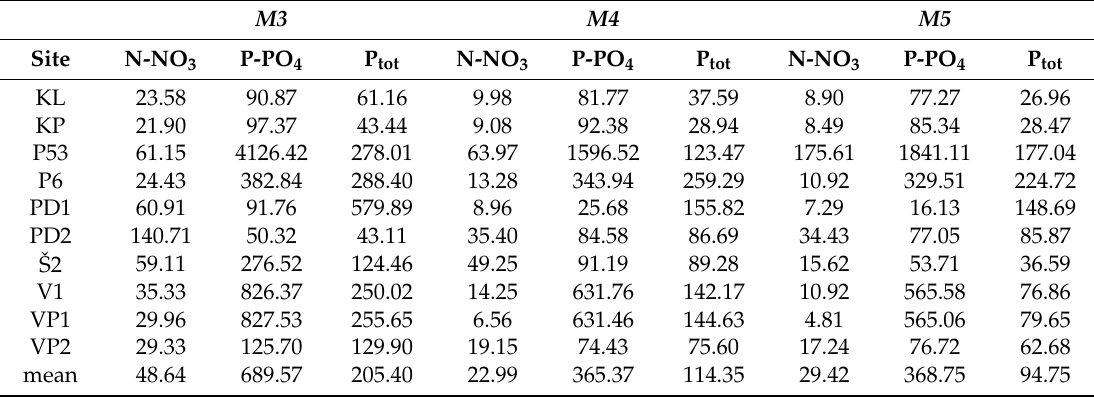
Table 6. Average monthly RMSE (%) of the M3 to M5 algorithms related to the true load (M6) for all the substances, sites, and monitored